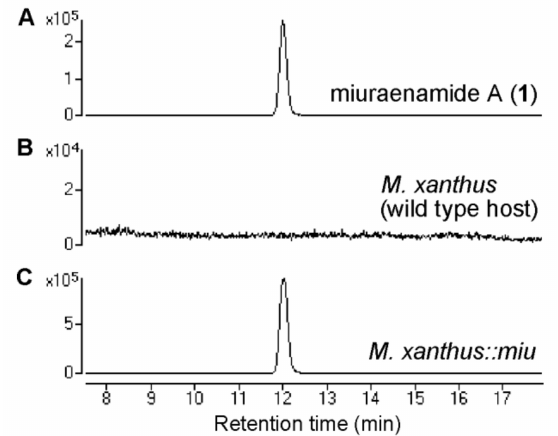
Figure 3. Production of miuraenamide A ( 1 ) using the heterologous transformant. Extracted ion chromatogram ( m/z 684.2216) of standard 1 ( A ), an extract of the wild-type host M. xanthus ( B ), and an extract of the heterologous transformant harboring miu cluster ( C ).